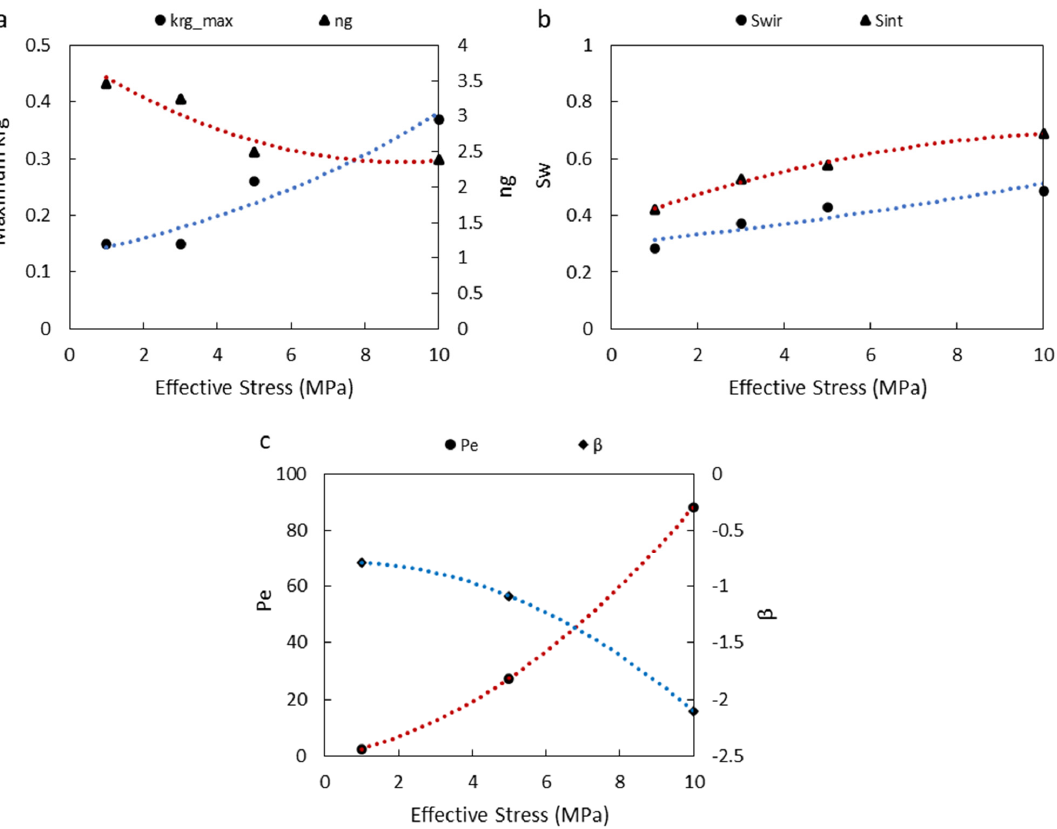
Figure 7. Changes in relative permeability and capillary pressure curves with effective confining stress using ( a ) maximum gas relative permeability and n g (B–C fitting parameter in Equation (15)), ( b ) irreducible water saturation and water saturation at the intersection point between gas and water relative permeability curves, and ( c ) entry capillary pressure P e and β (B–C fitting parameter in Equation (13)) of the fractured Calumet carbonate